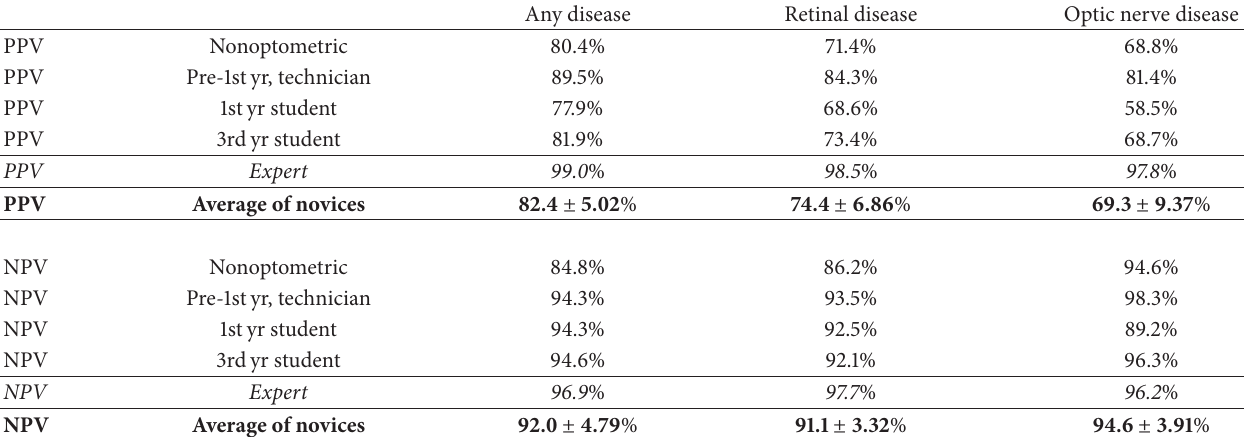
Table 2: Statistics and positive and negative predictive value (PPV and NPV).